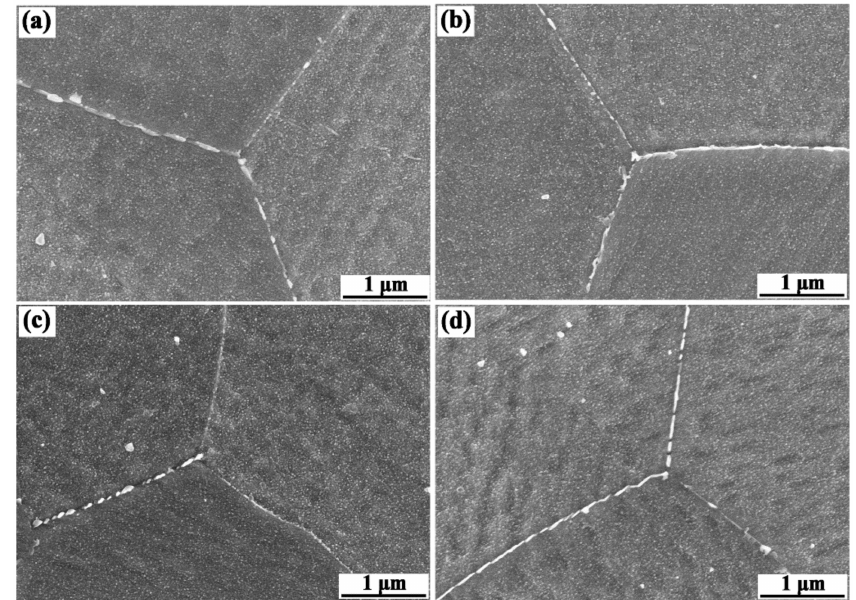
Figure 2. The microstructure of the alloys after direct aging heat treatment: ( a ) alloy 1, ( b ) alloy 2, ( c ) alloy 3, and ( d ) alloy 4.